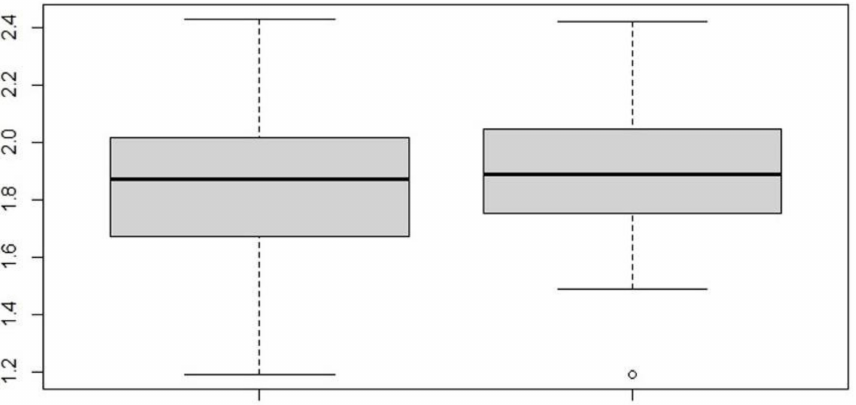
Figure 8. Boxplot for SOC comparison between training and test sets.